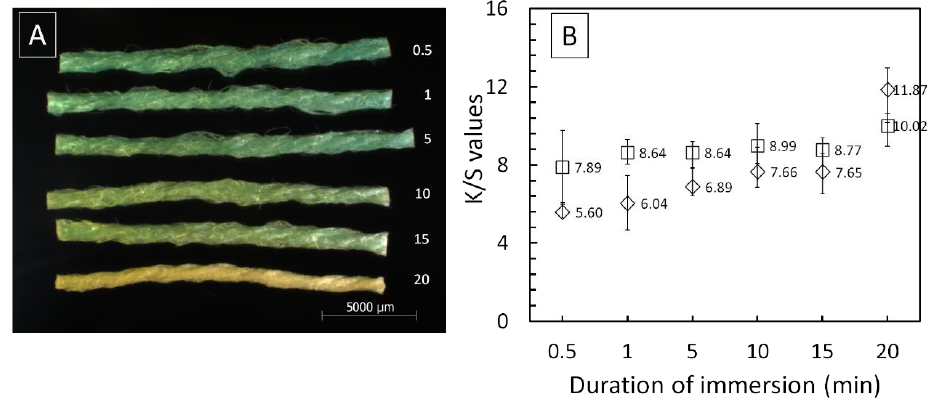
Figure 3. ( A ) Color transformation of CH(pH) int °GG(pH) PEC-coated fiber at 0.5, 1, 5, 10, 15 and 20 min of immersions and ( B ) K/S values of red (◊) and green (□) channels as a function of duration of immersions.